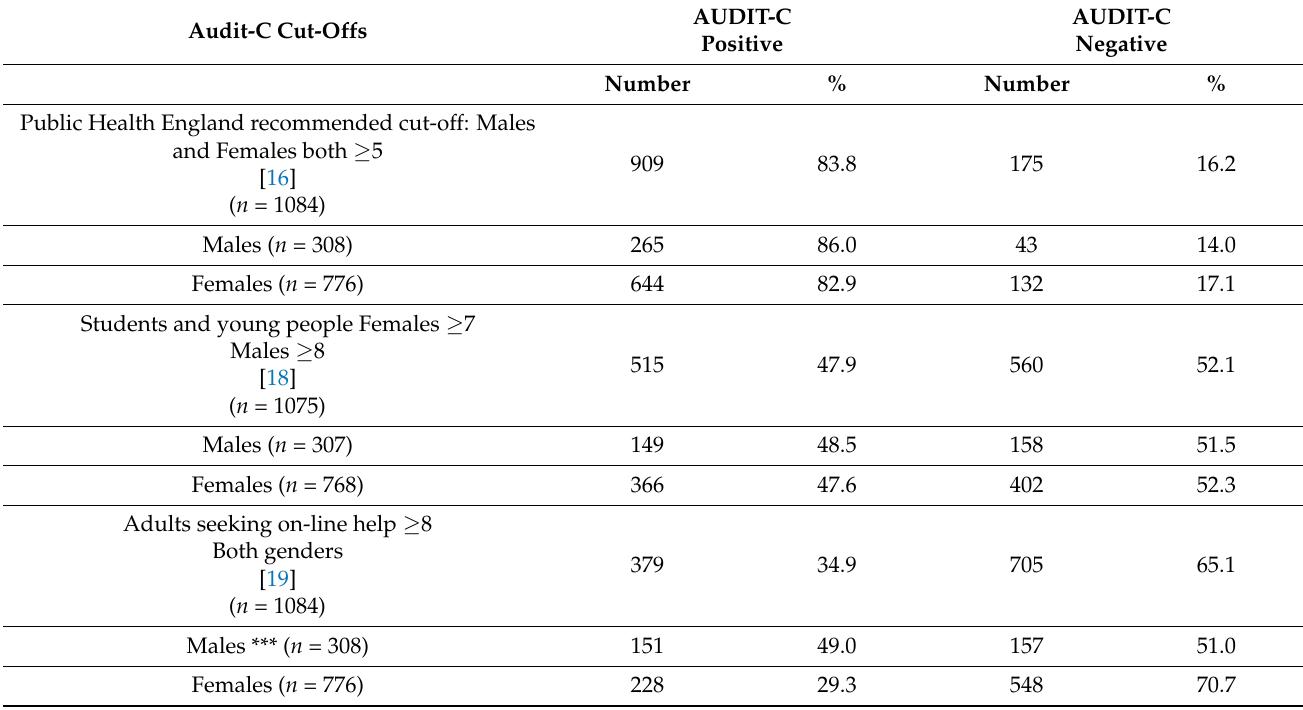
Table 2. AUDIT-C cut-offs used in this study and gender